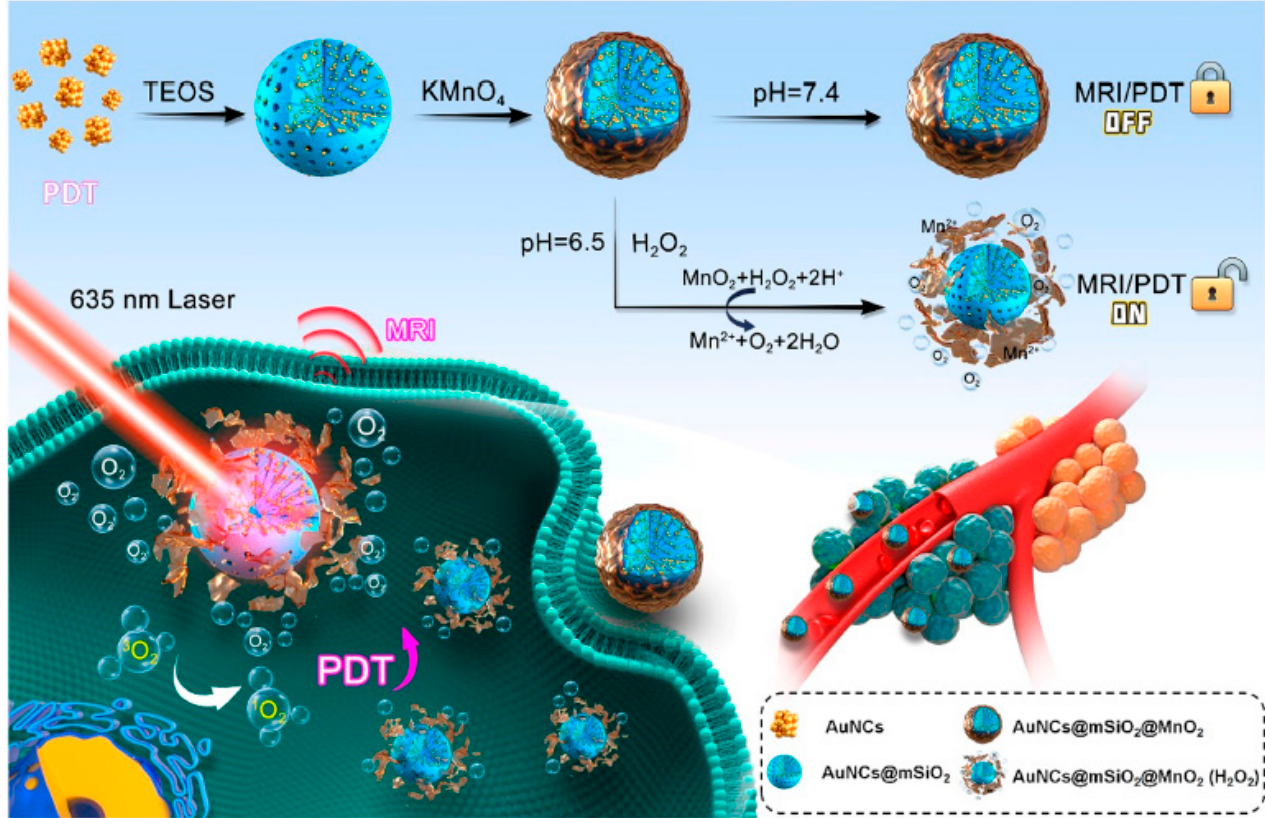
Figure 2. Schematic representation of synthesis and PDT efficiency of AuNC@mSiO 2 @ MnO 2 (H 2 O 2 ) nanosystem. Reproduced with permission [131]. Copyright 2021 ACS.